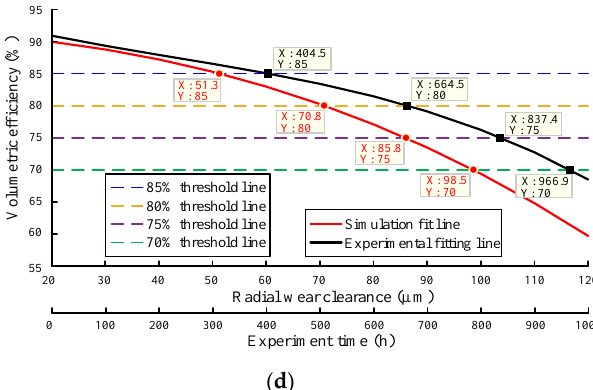
Figure 22. The fitting curve of the test data and the simulated fitting curve under the radial wear clearance: ( a ) Pump 1; ( b ) Pump 2; ( c ) Pump 3; ( d ) Pump 4.